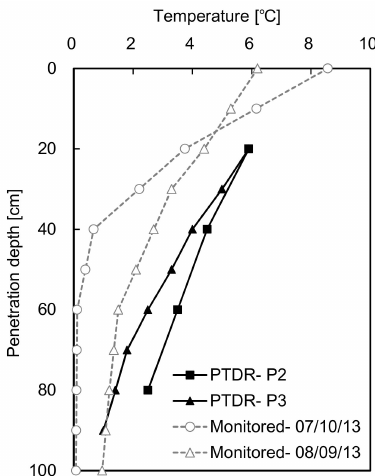
Figure 9. Temperature profiles obtained by PTDR. The dotted lines are the monitored temperature data in the same site reported by Byun et al.